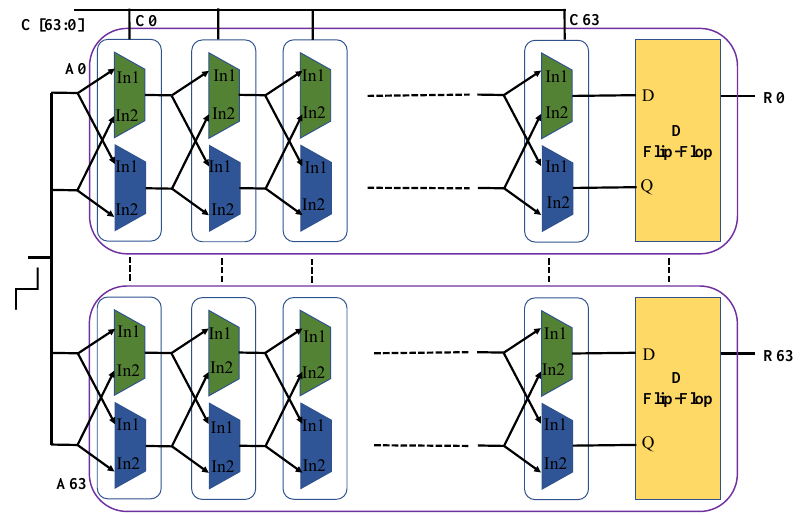
Figure 8. Architecture of 64-bit Arbiter